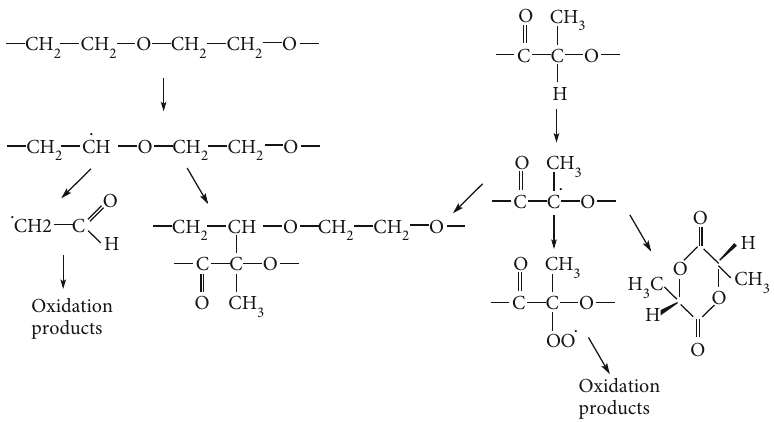
Scheme 1: Oxidative mechanism scheme of PLA/PEG blends.